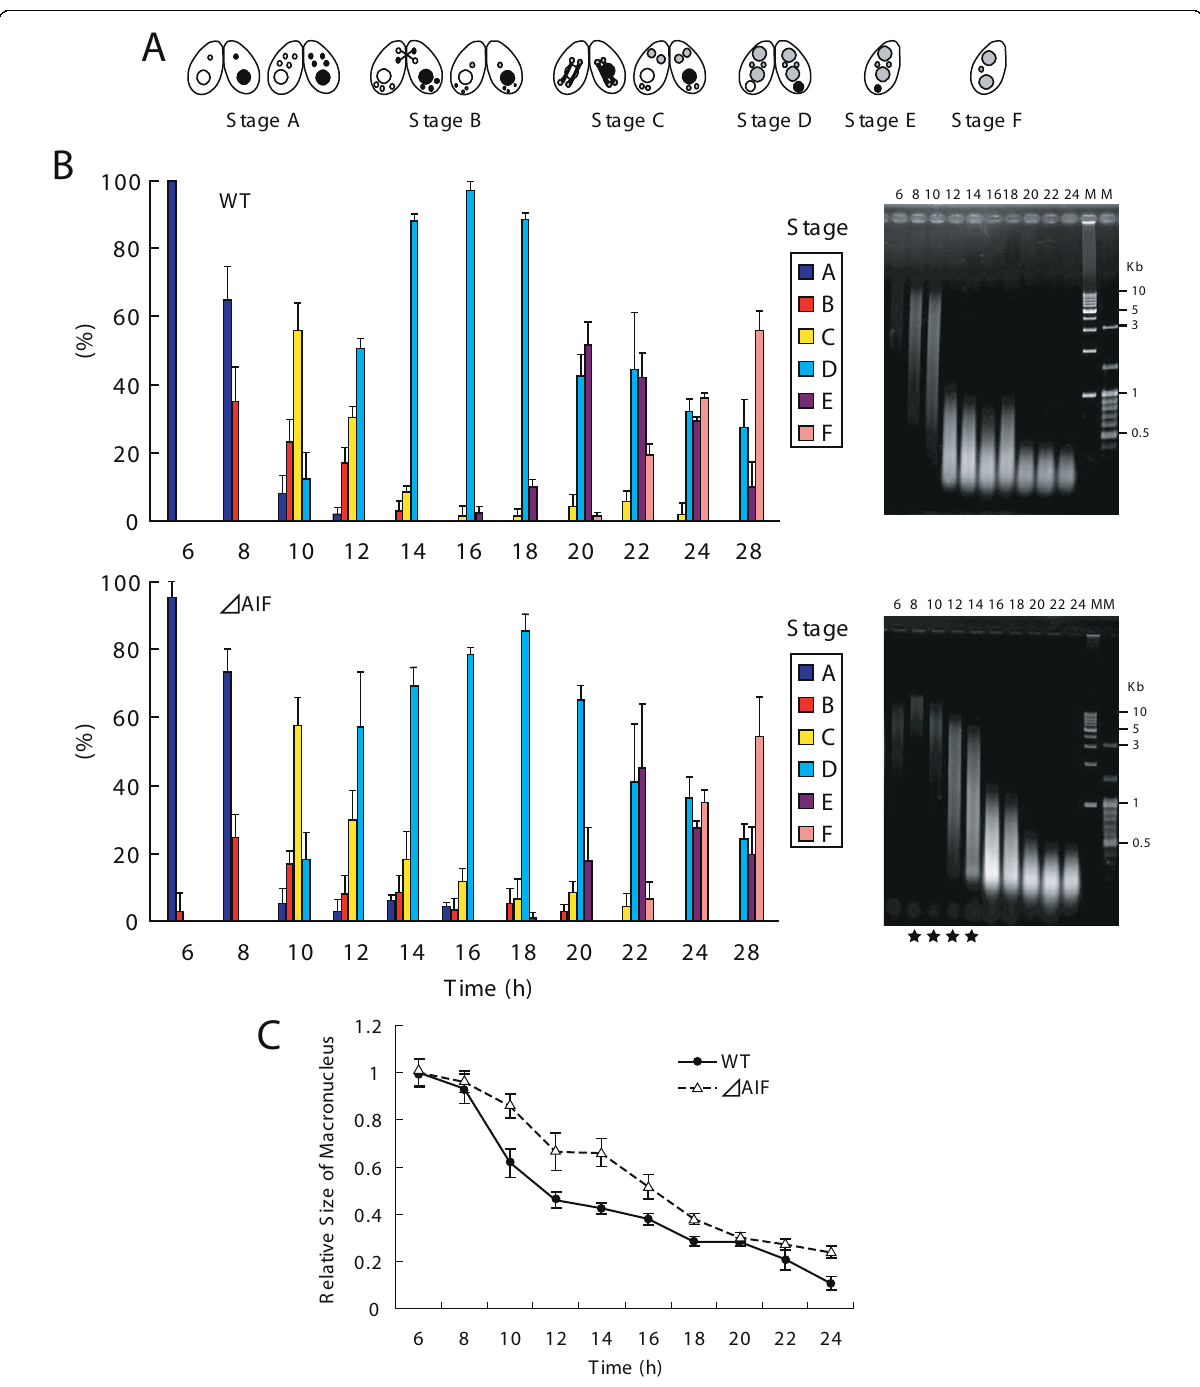
Figure 5 Progression of PND by disruption of AIF . A. Nuclear events during conjugation were divided into 6 stages (stage A ~stage F). B. Time course analysis of progression of the nuclear events in wild-type and Δ AIF between 6 h and 28 h after initiation of conjugation. The percentages of the nuclear stages were counted, and were expressed as a percentage of the total number of tested cells (300-400 cells). Columns and attached bars correspond to the means of four identical measurements and standard deviations. Fragmental DNA was isolated from the strains every 2 h during conjugation. The black stars between 8-12 h in Δ AIF indicate delay of kb-sized DNA fragmentation. M denotes kbp-ladder size marker (left) and 100-bp ladder size marker (right). C. Changes in size of parental macronuclei between 6 h and 28 h after initiation of conjugation. Columns (points) and attached bars correspond to the means of four identical measurements (80-100 cells) and standard